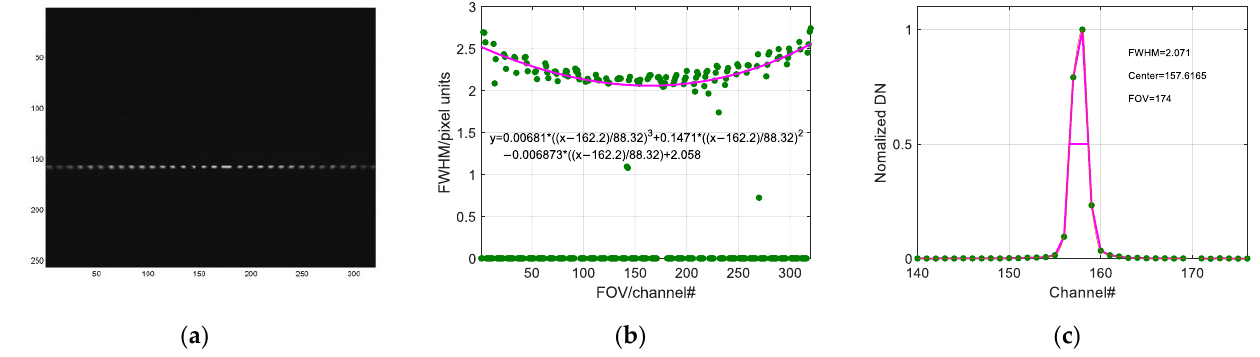
Figure 17. Imaging of the straight slit at 123 K. ( a ) The image of the straight slit; ( b ) the FWHM of the inclined slit image; ( c ) the discrete sampling curve of the inclined slit image by pixels.